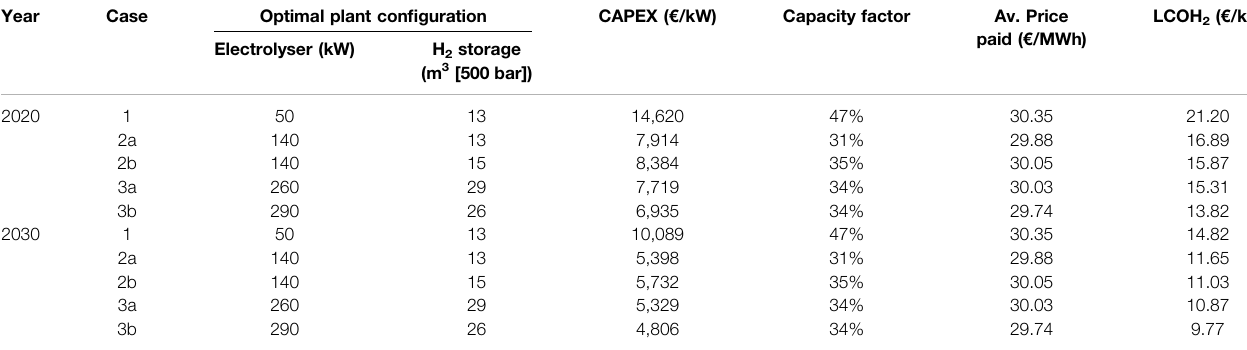
Note. LCOH 2 without waste heat (WH) or O 2 recovery.